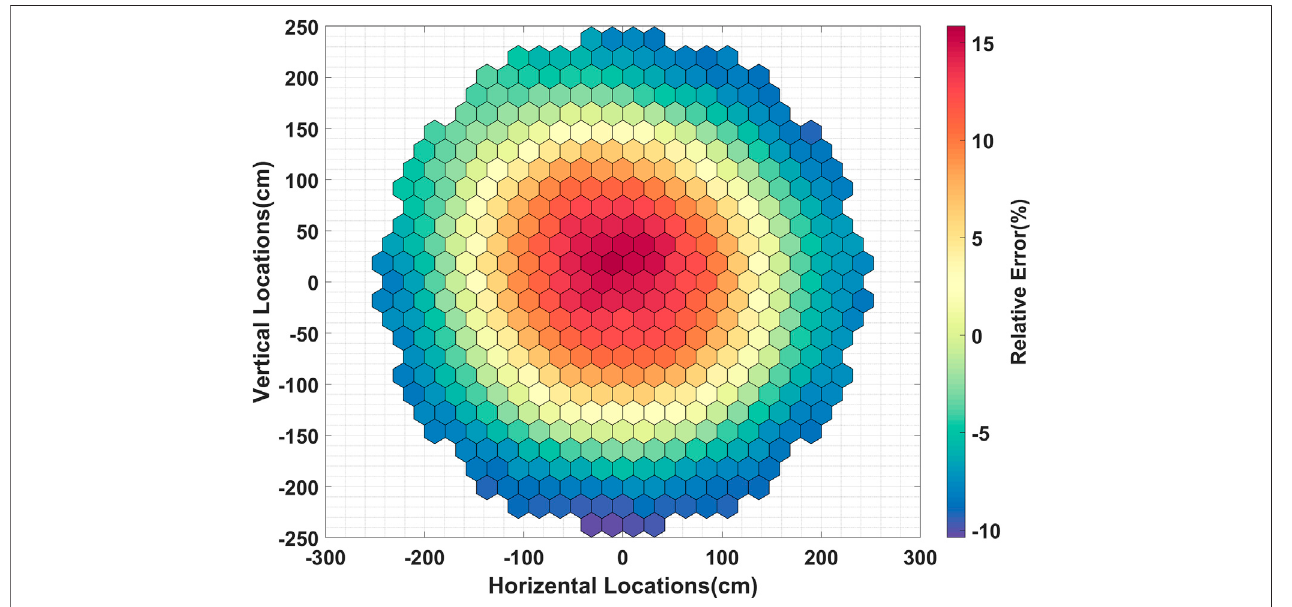
FIGURE 11 | The fi ssion rate relative error between the Monte Carlo calculation and the combined fi ssion matrix theory with correction ratio.